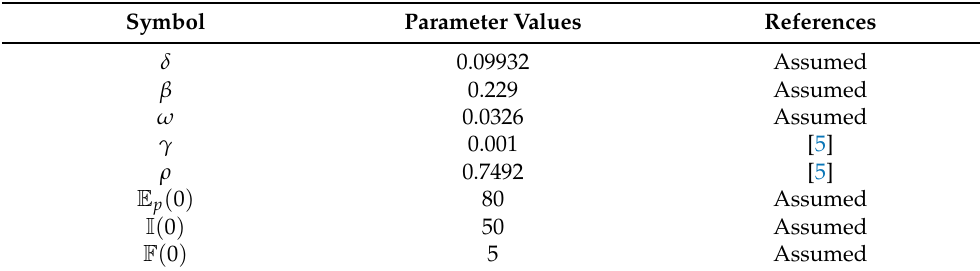
Table 1. Parameters and their values.